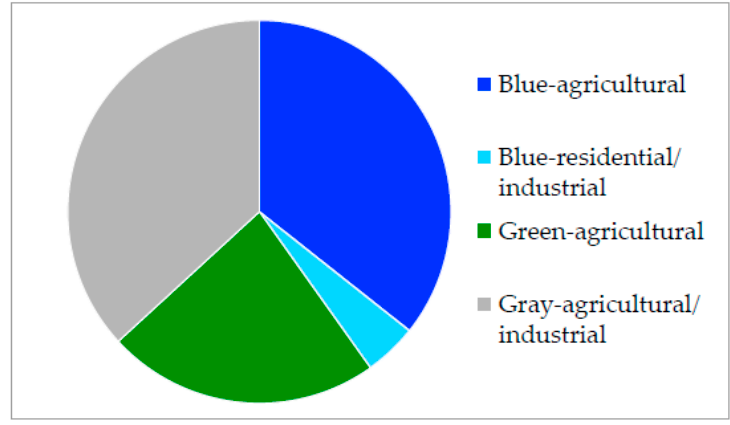
Figure 1. California’s water footprint (calculated on a volumetric basis) for products and services produced within the state, whether consumed locally or exported. Based on data presented by the Pacific Institute [16].